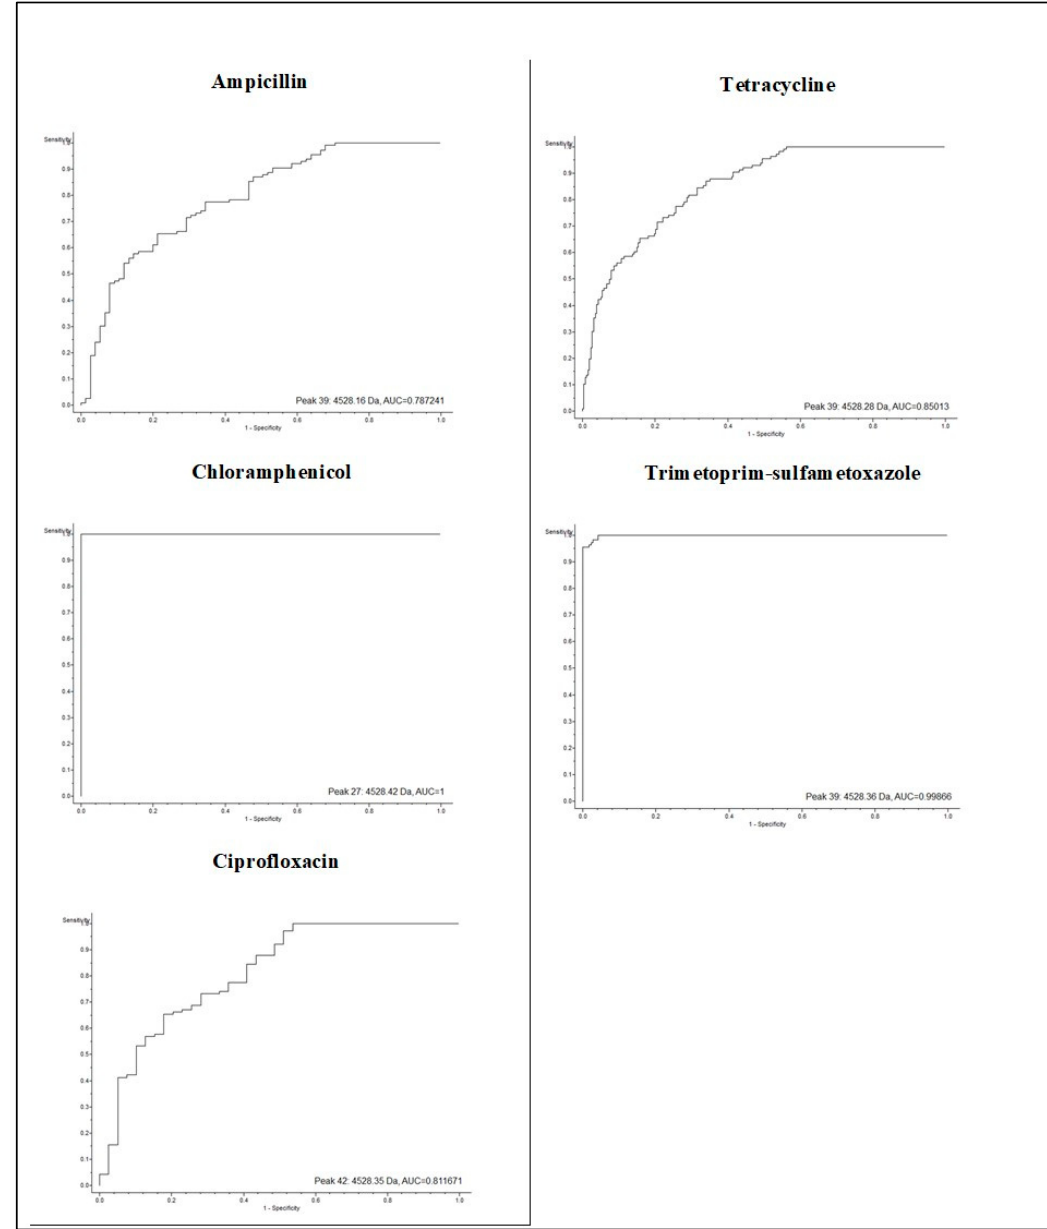
Figure 2. Area under the receiver operating characteristic (ROC) curve (AUC) value for the peak at 4528.42 m/z obtained from an E. coli culture grown in the presence of different antibiotics. The ROC curve allows us to know the sensitivity and specificity of a test, and the area evaluates discrimination, which is the ability of the test to correctly classify positive and negative tests.